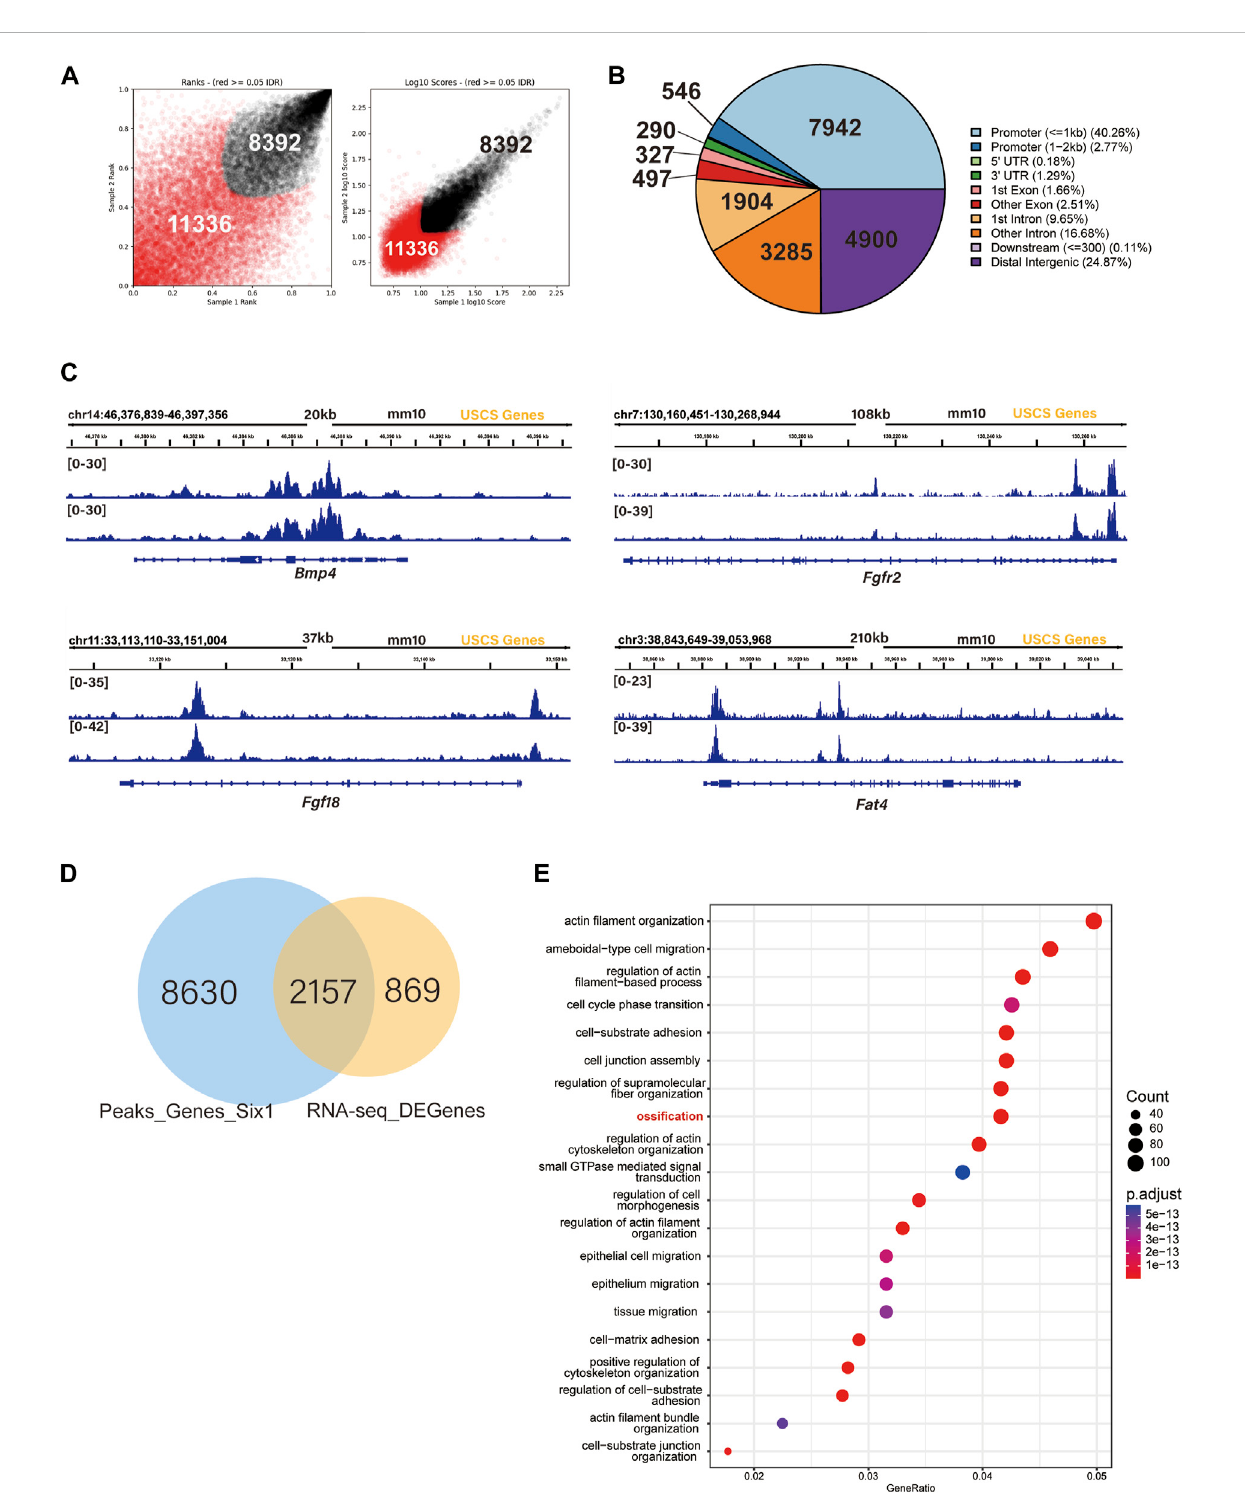
FIGURE 6 SIX1 directly regulates the promoter of osteogenic differentiation-related genes. (A) IDR tests the peaks of two biological replication. (B) Genomic distribution of Six1 -enriched regions. (C) Six1 directly binds the promoter of Bmp4 , Fgfr2 , Fgf18 , and Fat4 . (D) A Venn diagram indicating overlap of Six1- binding genes and RNA-seq DEGs. (E) GO enrichment analysis of shared genes between Six1-binding genes and RNA-seq